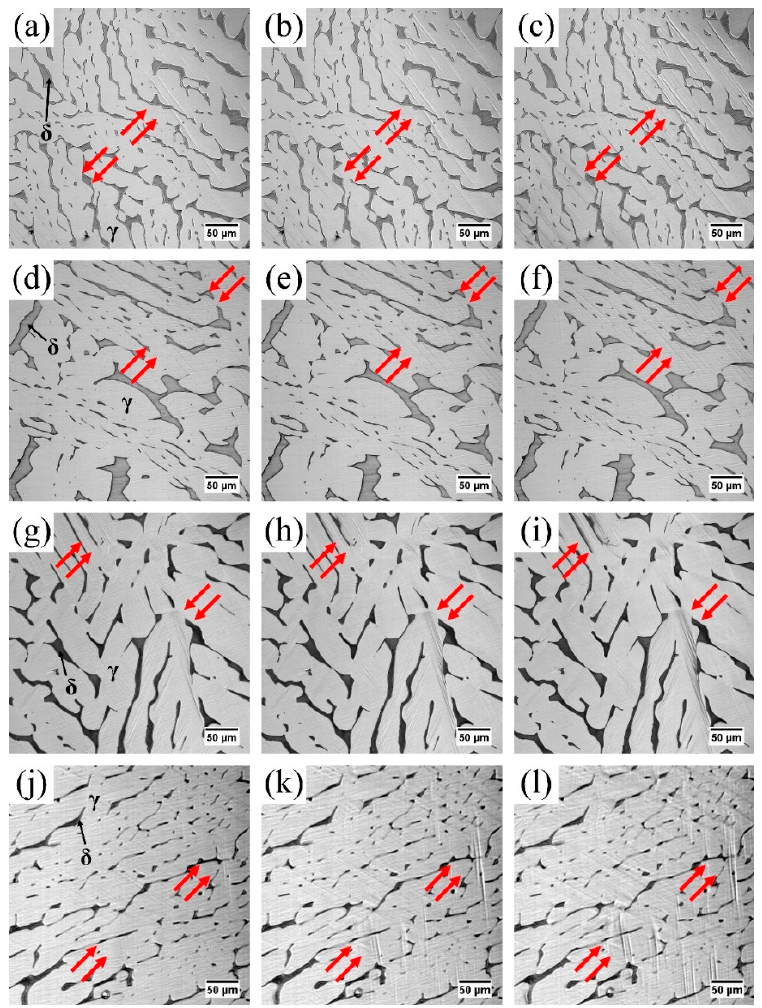
Figure 5. The primary stage of the plastic deformation of Z3CN20.09M CDSS. Figure ( a ), ( b ) and ( c ) were the “as received, 20 °C” condition. Figure ( d ), (e) and (f) were the “as received, 320 °C” condition. Figure ( g ), ( h ) and ( i ) were the “aged 2000 h, 320 °C” condition. Figure ( j ), ( k ) and ( l ) were the “annealed 3 h, 320 °C” condition. The tensile axis is along the horizontal direction in all the figures. 𝛾 denotes austenite phase, and 𝛿 is the ferrite phase.